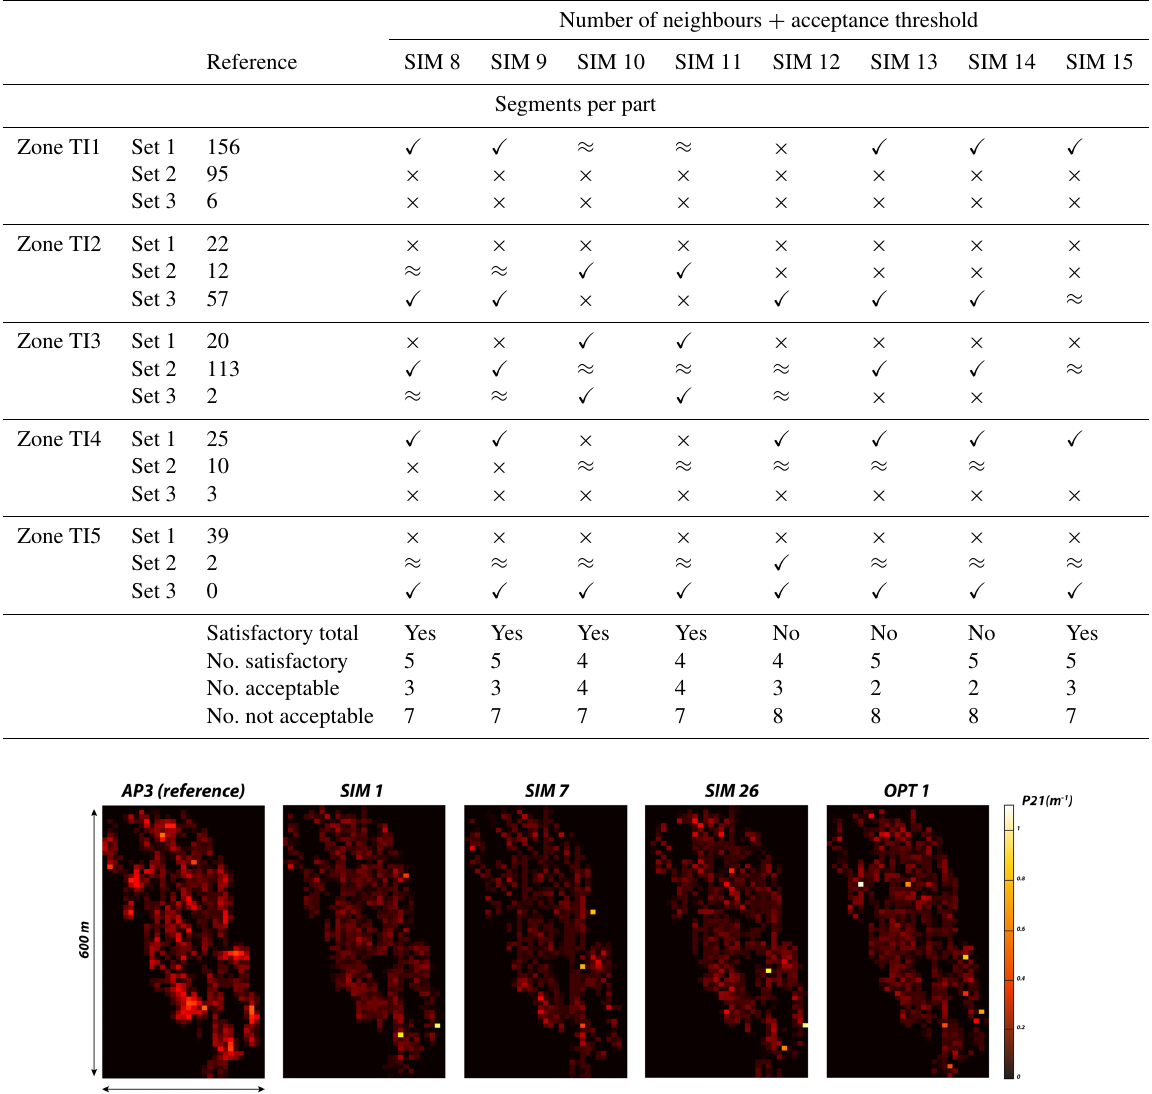
Table 5. Results of the sensitivity analysis on the influence of the number of neighbours and on the variation of the acceptance threshold. The symbols are the same as those used in Table 4.